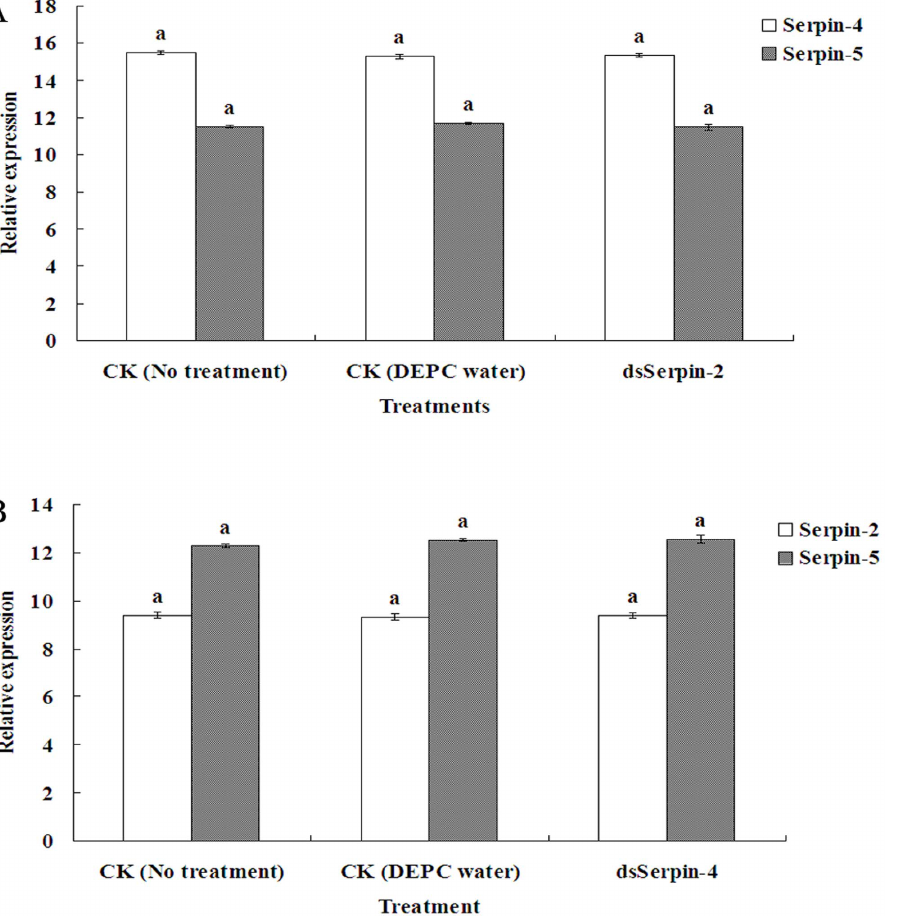
Figure 8. Expression of serpin-4 and serpin-5 after injecting dsSerpin-2 (A), expression of serpin-2 and serpin-5 after injecting dsSerpin-4 (B). Each value was shown as values 6 S.E.M of three independent experiments. Significant differences were indicated with different letters at P , 0.05.